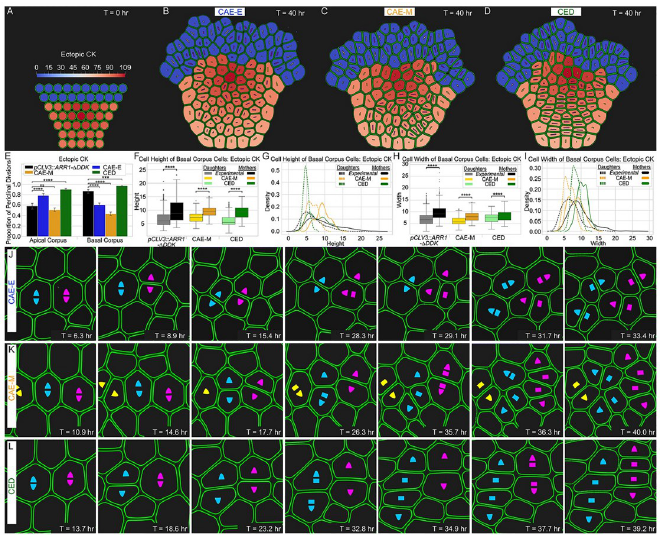
Fig 6. Quantitative comparison of experimental data with simulation results for ectopic misexpression of CK. (A) The spatial distribution of CK was expanded in the deeper layers to be analogous with ectopic misexpression of CK experiments (see the “Model description” section for details). (B-D) Final time point of ectopic CK simulations for all three mechanisms. (E) Proportion of periclinal divisions for three mechanisms compared to experiments in ectopic misexpression of CK simulations. Mother and daughter cell height (F) boxplots and (G) distributions for the CAE-M and CED mechanisms in ectopic CK simulations. Comparison of mother and daughter cell widths (H) boxplots and (I) distributions for the CAE-M and CED mechanisms in ectopic CK simulations. Significance tests in (F,H) were performed using independent t-tests. Asterisks indicate significance at the following levels: � (p � 0.05), �� (p � 0.01), ��� (p � 0.0001), ���� (p � 0.00001), ns (p > .05). (J) Time series of cell division and expansion events in CAE-E simulations. (K) Time series of cell division and expansion events in CAE-M simulations. (L) Time series of cell division and expansion events in CED simulations. CK induced increase in periclinal cell divisions coupled with CK induced apical-basal expansion of cells leads to the formation of characteristic “strips” in the Basal corpus. The CED mechanism is the only mechanism that can reproduce experimentally observed SAM growth patterns in this region. S3 Fig provides extended analysis between ectopic misexpression of CK SAMs in experiments and simulations for all four hypothesized mechanisms presented in this